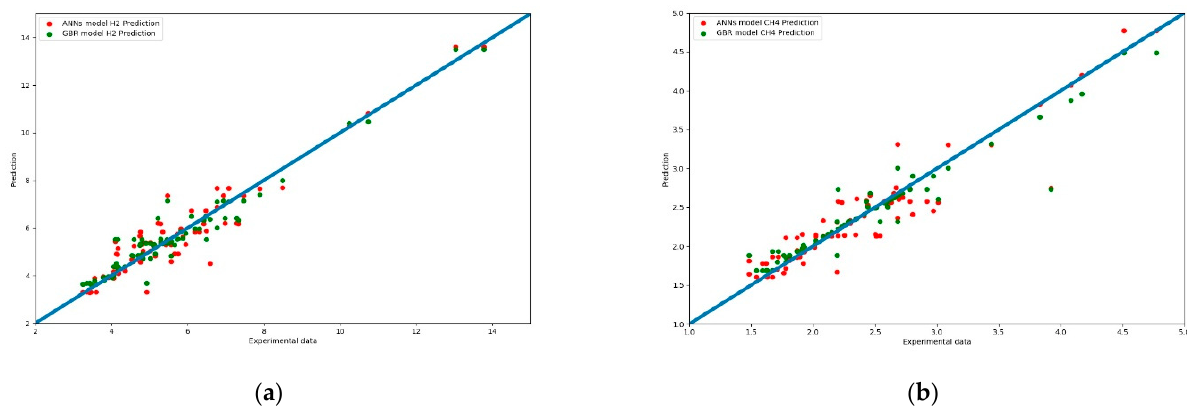
Figure 13. ( a ) Scatter plot of the comparison of syngas compositions in H 2 prediction between the experiment data for the ANN and GBR model. ( b ) Scatter plot of the comparison of syngas compositions for CH 4 prediction among the experiment data for the ANN and GBR